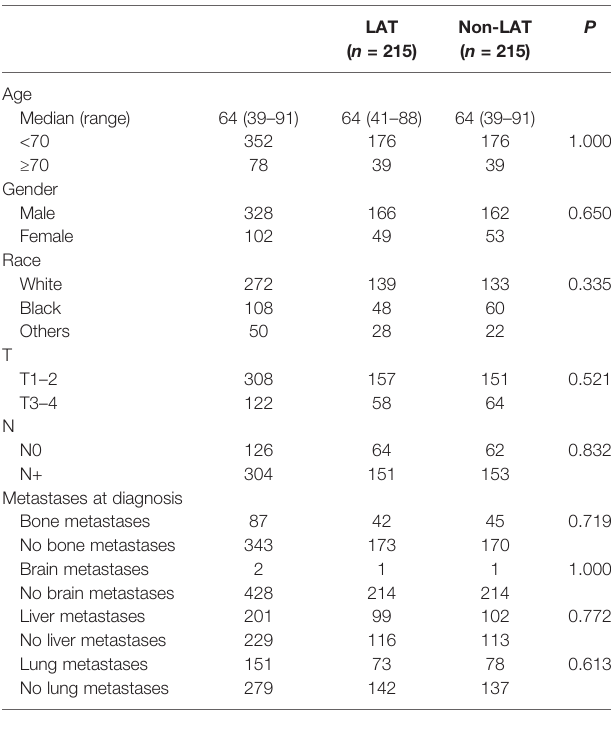
TABLE 3 | The clinical parameters of matched LAT and non-LAT groups.